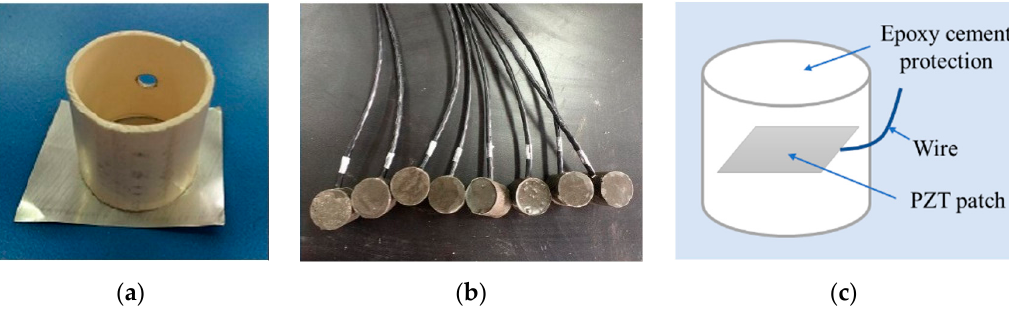
Figure 1. Fabrication of piezoelectric intelligent modules: ( a ) A homemade mold; ( b ) piezoelectric intelligent modules; ( c ) schematic of the module.